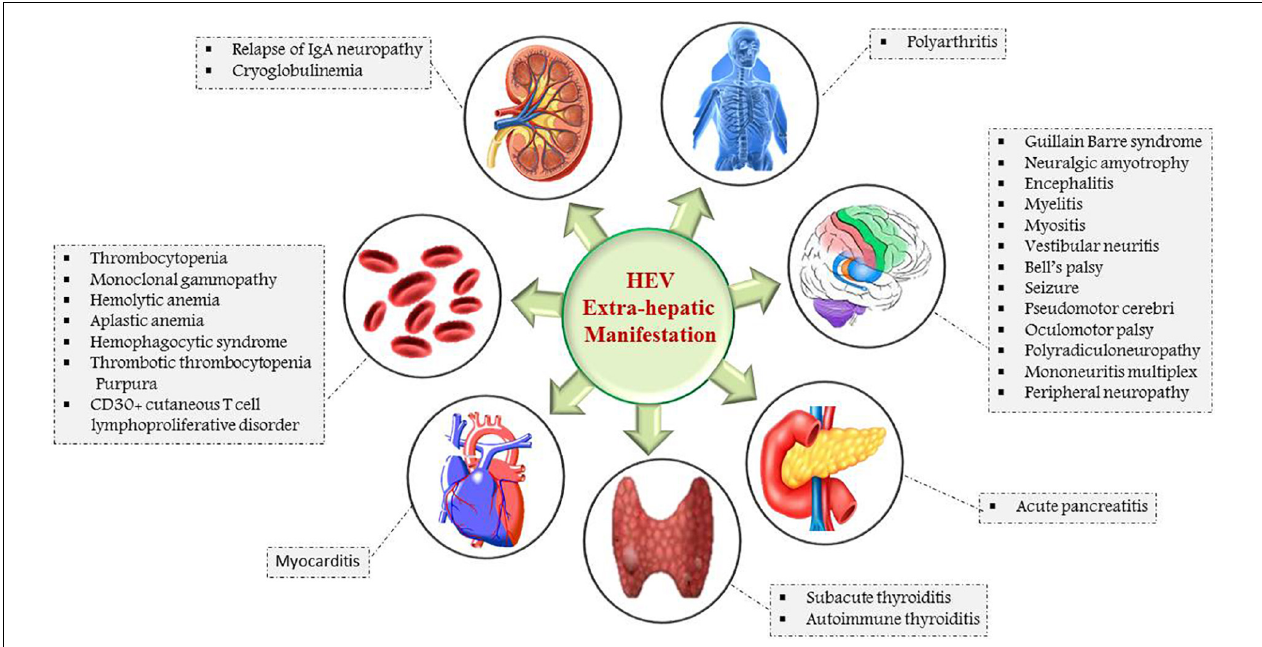
FIGURE 4 | Schematic representation of extra-hepatic manifestations of HEV infection: Myocarditis and acute pancreatitis are the HEV associated manifestations of heart and pancreas. The major neurological and hematological manifestations are Guillain Barre syndrome, Bell’s palsy, neuralgic amyotrophy, thrombocytopenia, hemolytic, and aplastic anemia. Cryoglobulinemia is attributed by renal, whereas polyarthritis is associated with skeletal-related HEV manifestations.